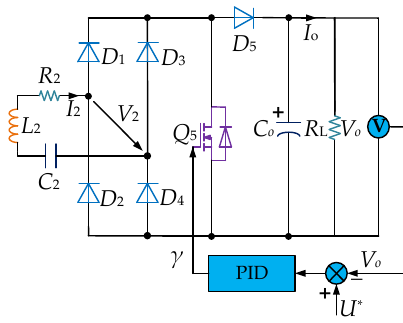
Figure 3. Control structure at the secondary side.